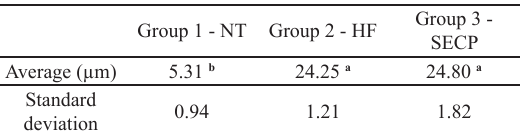
Figure 7. Surface morphology of the sample surfaces: a) without surface treatment (NT); b) after conditioning with hydrofluoric acid (HF); c), after conditioning with self-etching ceramic primer (SECP). Table 4. Average of the bond strength values (MPa), standard deviation and statistical analysis (equal letters means without statistical difference) of the e.max CAD CAM glass ceramic, without conditioning (NT), etched with hydrofluoric acid solution (HF) and with SECP